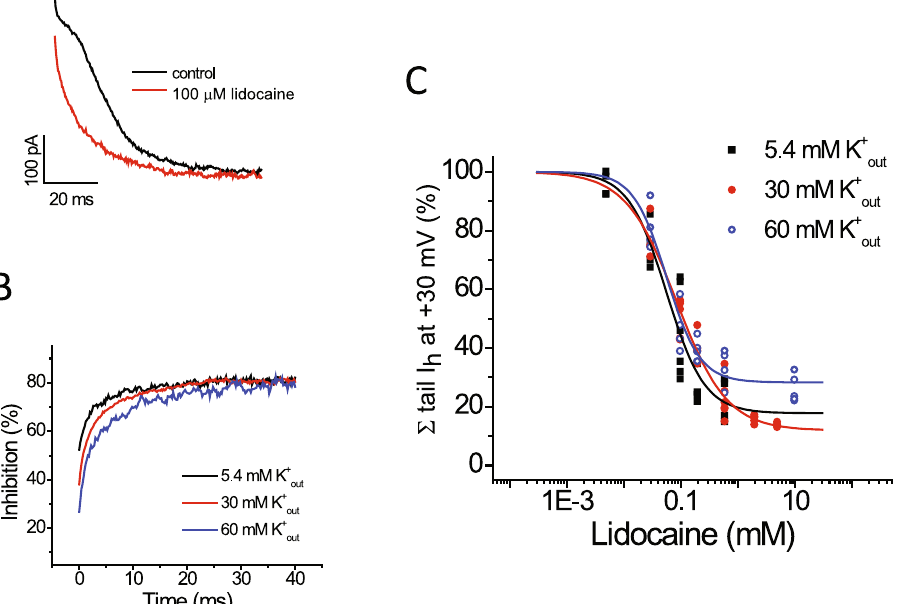
Figure 6. Lidocaine inhibition of HCN1-mediated I h is unaltered at + 30 mV by raising the concentration of extracellular potassium ( A ). Representative traces of outward tail I h relaxation, recorded at + 30 mV following hyperpolarization to − 130 mV from a holding voltage of − 35 mV, under control conditions and following application of 100 µ M lidocaine, at 30 mM extracellular potassium. The tail currents are shown after 1 ms in order to remove any contribution from the capacitive transient and clarity. ( B ) Mean time courses of lidocaine (600 µ M) inhibition of the outward I h at different concentration of extracellular potassium (5.4, 30, and 60 mM) obtained by normalizing tail currents in the presence of lidocaine from those recorded in control solutions as shown in ‘ A ’. Time courses were fit with double exponential equations. The extent of inhibition at the beginning of the voltage pulse to + 30 mV increased over the course of deactivation for each concentration of extracellular potassium. The initial value for inhibition was larger for the lower concentrations of extracellular potassium, and they reflected the mean values plotted in Fig. 4C. Maximum inhibition reached a plateau and was the same at all potassium concentrations (~70–80%). Raising extracellular potassium from 5.4 to 60 mM did not significantly alter either the fast or slow time constants of lidocaine block, which varied from 1.1 ± 0.13 to 1.33 ± 0.15 ms and from 8.1 ± 0.25 to 9.6 ± 0.9 ms (n = 4–5; ANOVA, P = 0.66 and 0.51), respectively, in the presence of 600 µ M lidocaine. ( C ) Plots of normalized charge transfer versus lidocaine concentration at different extracellular potassium concentrations (5.4, 30, and 60 mM). To estimate the total charge transferred, the area under leak subtracted traces of tail I h relaxation was calculated by integration and those calculated in the presence of lidocaine were normalized to those calculated in the absence of lidocaine. The solid line represents a fit using the Hill equation, which produced IC 50 values of 56 ± 12, 84 ± 8, and 56 ± 7 µ M (n = 4–6; ANOVA, P < 0.0001), Hill coefficients of 1.3 ± 0.3, 0.98 ± 0.11, and 1.49 ± 0.23, and maximum inhibitions of 82.2 ± 6.9, 88.1 ± 2.4, and 71.7 ± 2.4%, 5.4, 30, and 60 mM extracellular potassium, respectively. Values shown are those collected from individual